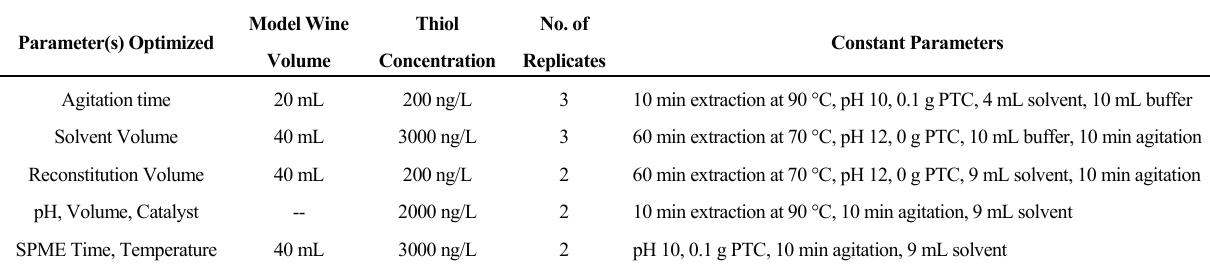
Table A1. Conditions used for optimization of derivatization and HS-SPME